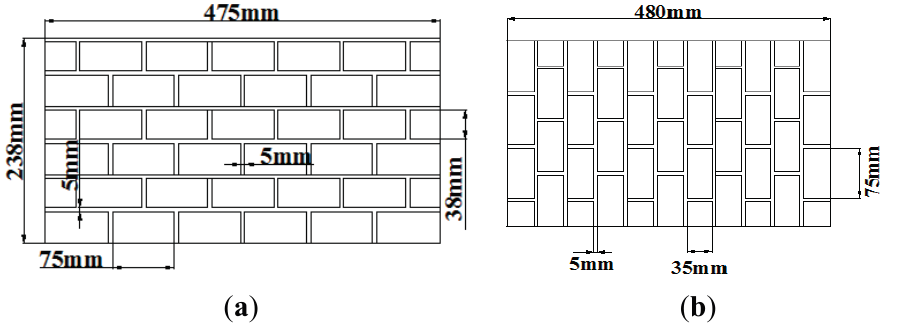
Figure 14. Layout of Type-1 and Type-2 masonry panels for out-of-plane bending test: ( a ) Type-1 and ( b )